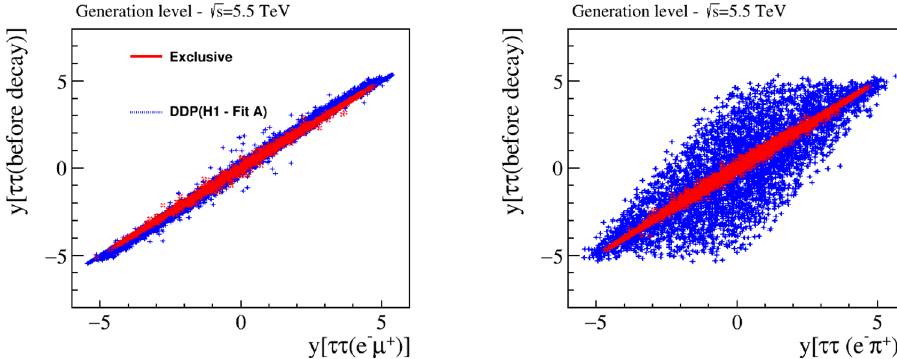
Fig. 3 Correlation between the rapidity of the τ + τ − system and the purely leptonic pair (left panel) and the semileptonic system (right panel) generated in the decays for the 1-prong